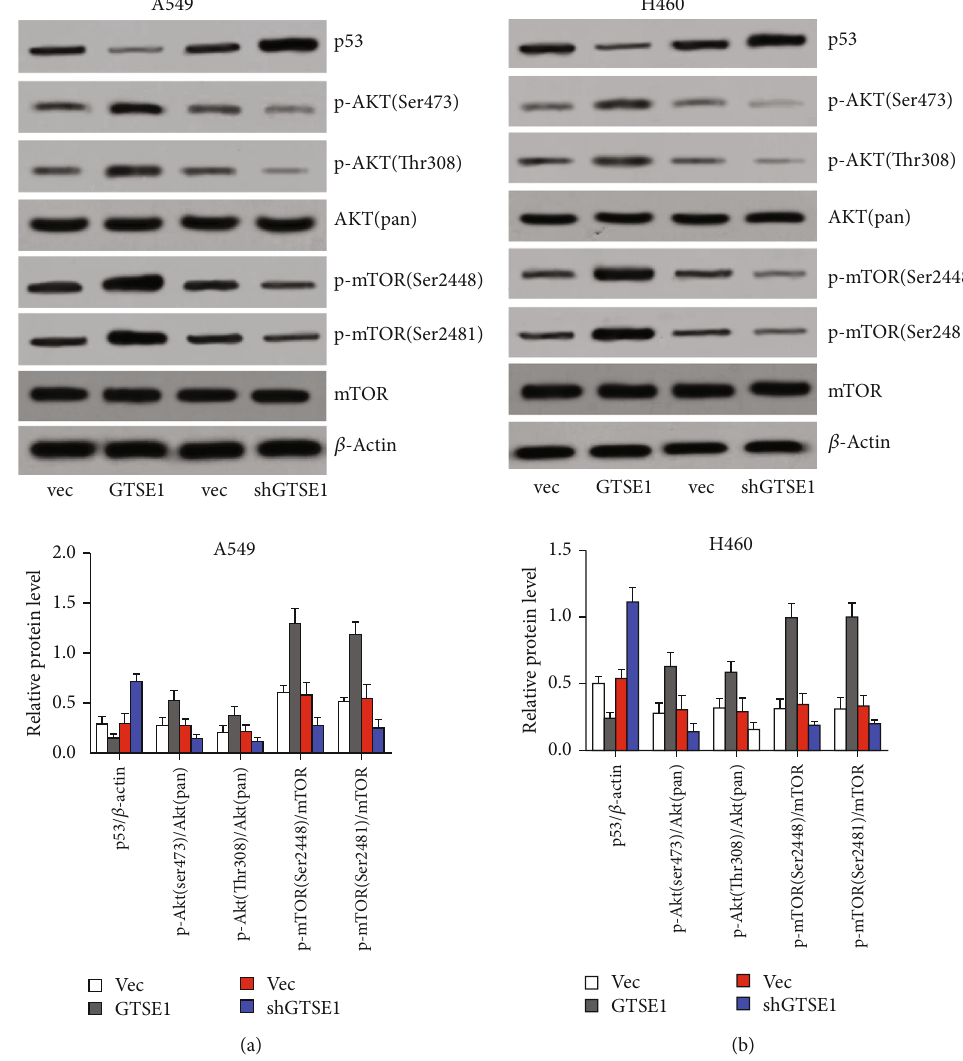
Figure 6: GTSE1 activated AKT signaling in H460 and A459 cell lines. (a, b) GTSE1 was overexpressed and silenced in both A549 and H460 cells. p53 protein, phosphorylation of Akt, and mTOR protein level were detected by the western blotting assay. ∗ p < 0 : 05